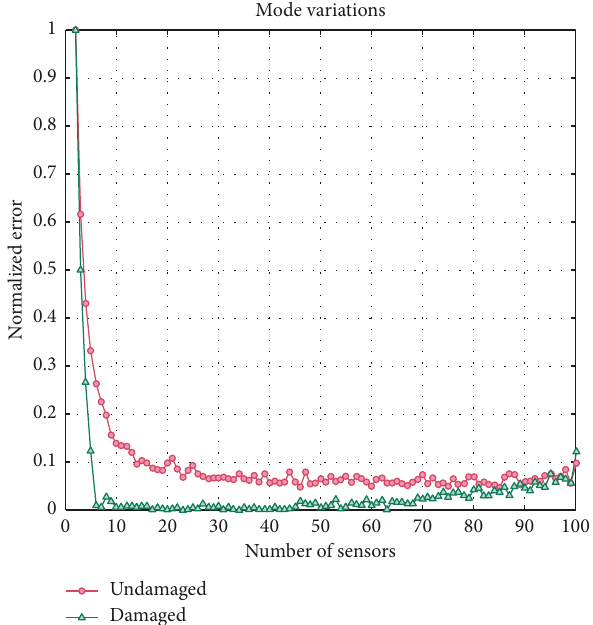
Figure 17: Normalized error function of the structure accounting for different scenarios: undamaged and damaged structure of Hall B.